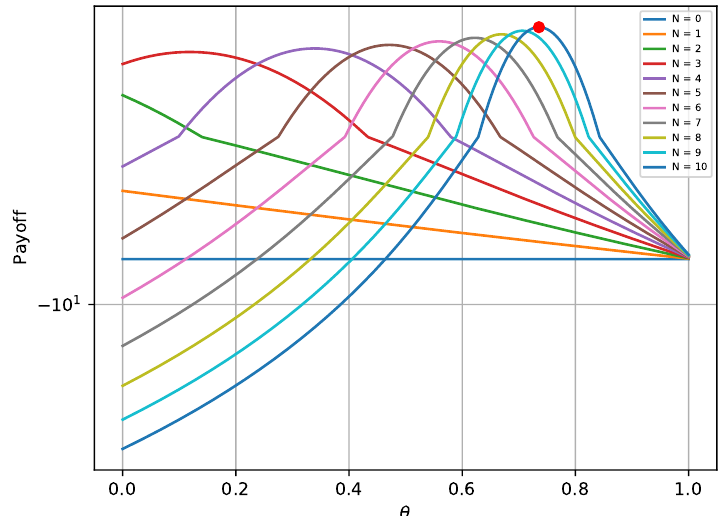
Figure 3. Defender’s payoff for different strategies in the one-shot